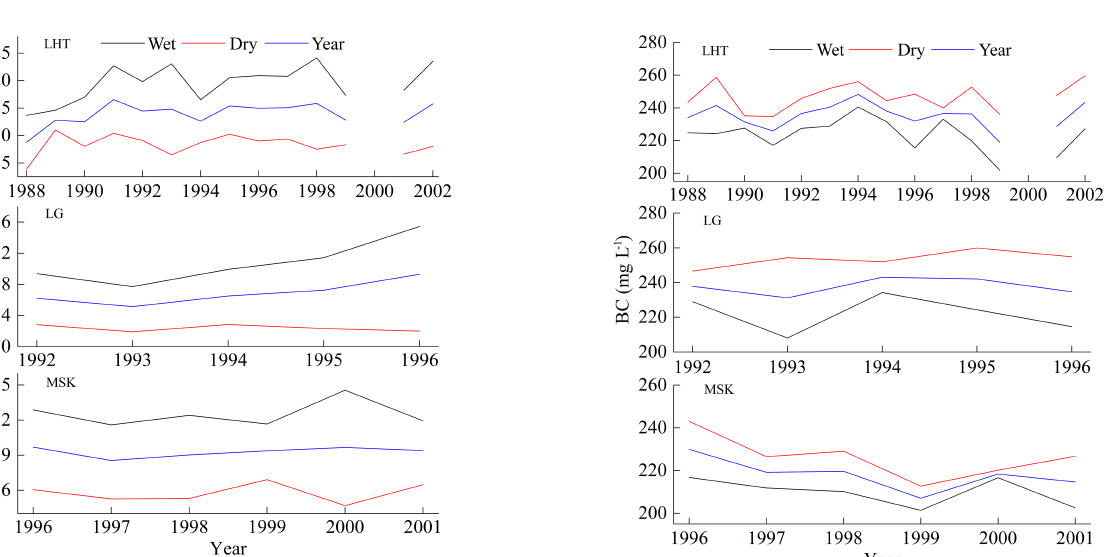
(239.1 mg L − 1 ; Fig. 7). Differences of carbon sink